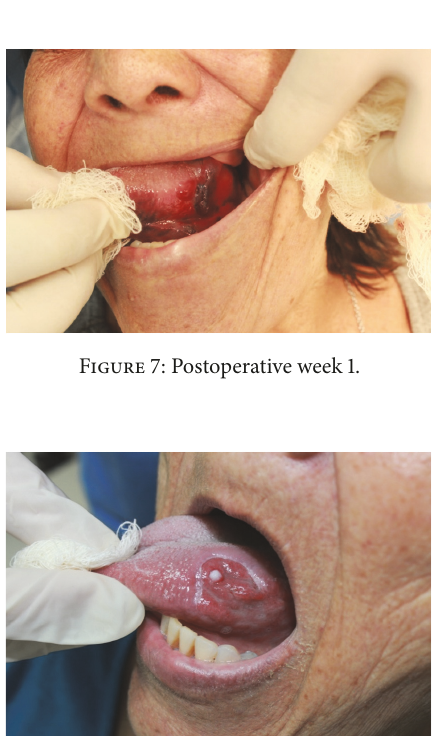
Figure 8: Postoperative week 3.